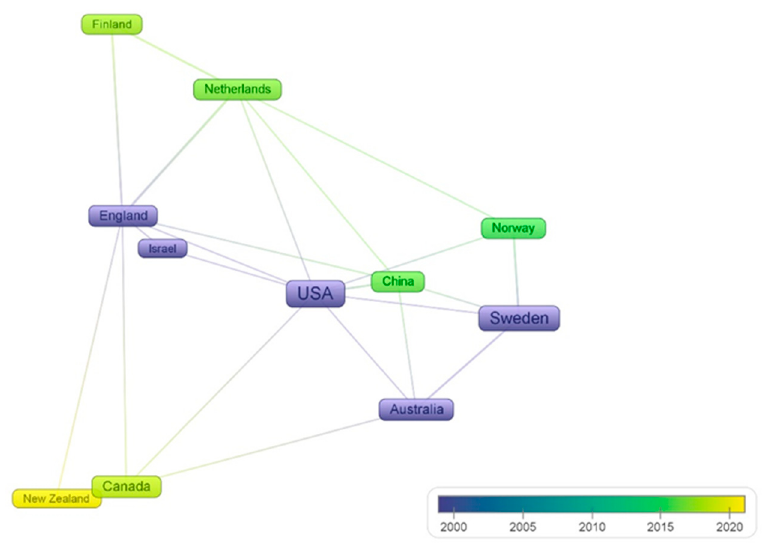
Figure 3. Distribution of major countries/regions in the time dimension.